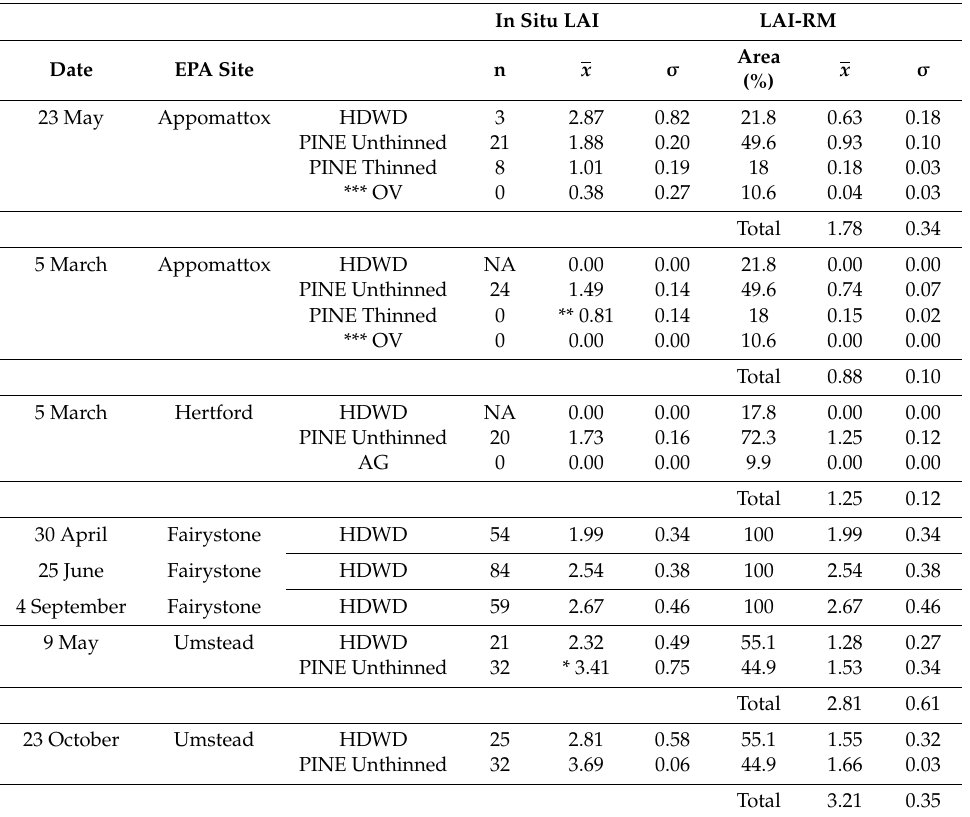
Table 5. 1.0kmupscaledinsituLAIacrossfourresearch sites(HDWD—hardwood,